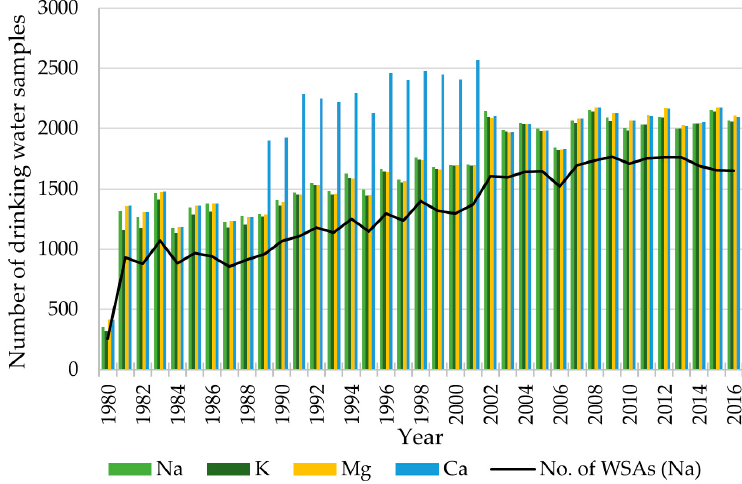
Figure 2. Number of drinking water samples per year for Na, K, Mg and Ca and number of water supply areas (WSAs) with water samples, 1980–2016.